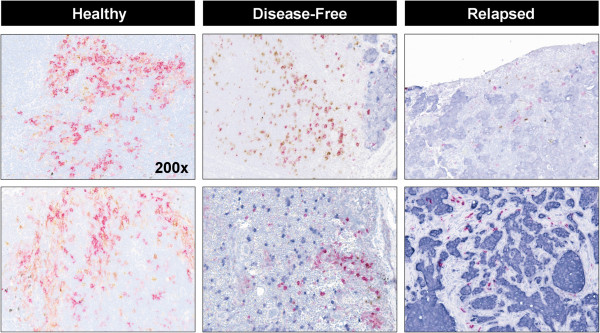
Immunohistochemistry-Stained Images of DC Clusters. Immunohistochemistry stained images of DC (dendritic cell) clusters from two each healthy, disease-free and relapsed patients. Stains include: Magenta (CD1a, Immature DCs), Brown (CD83, Mature DCs), Blue (Hematoxylin, Non-DC cells). The dark purple cells are pan-cytokeratin-stained tumor cells. Note the increased number and density of DCs in control nodes. All images were taken at 200× resolution.